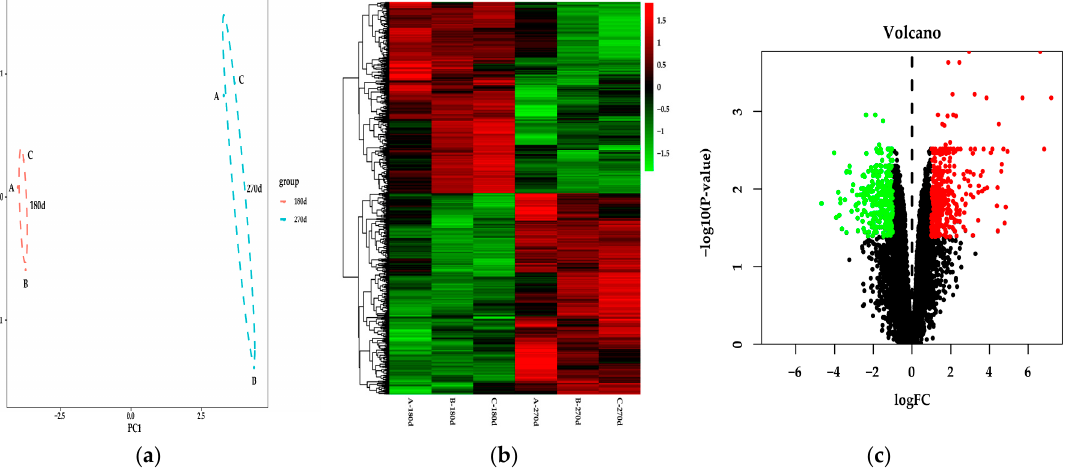
Figure 1. DEGs were identified in Holstein dairy cow mammary gland from mid lactation versus the cows from late lactation. ( a ) Principal component analysis (PCA) of the differentially-expressed gene (DEG) expression profiles. ( b ) Heat map of the DEGs. Green indicates downregulated DEGs and red indicates upregulated DEGs. ( c ) Volcano plot displays DEGs in Holstein dairy cow mammary glands during mid lactation and late lactation.